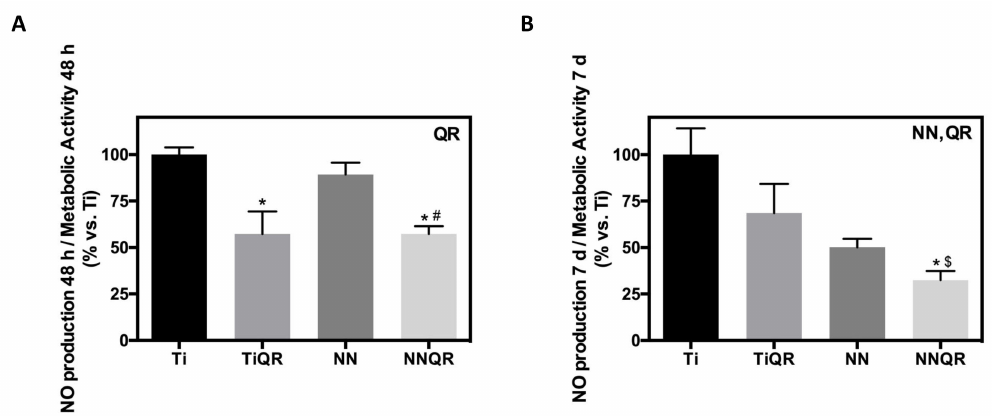
Figure 4. HUVEC NO production corrected by metabolic activity levels. ( A ) NO production corrected by metabolic activity levels after 48 h of incubation; results are expressed as % vs. Ti ( n = 7). ( B ) NO production corrected by metabolic activity after 7 d of incubation; results are expressed as % vs. Ti. Values represent the mean ± S.E.M ( n = 7). Results were statistically compared by an ANOVA and Bonferroni as a post hoc for NO production 48 h and Kruskal–Wallis for NO production 7d. * p < 0.05 versus Ti; $ p < 0.05 versus TiQR; # p < 0.05 versus NN. QR indicates e ff ect of quercitrin functionalization ( p < 0.05); NN indicates e ff ect of nanostructuration ( p < 0.05) as assessed by a Student’s t -test for NO production 48 h or Mann–Whitney for NO production 7